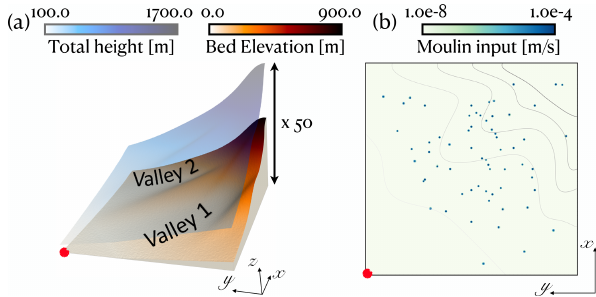
Figure 9. Synthetic square topography for runs R 0 to R 4 : (a) ex- truded bed elevation (showing two valley regions) and ice height and (b) location of the moulins and isocontours of bed elevation. The red dot in both images shows the location of the lowest eleva- tion – the